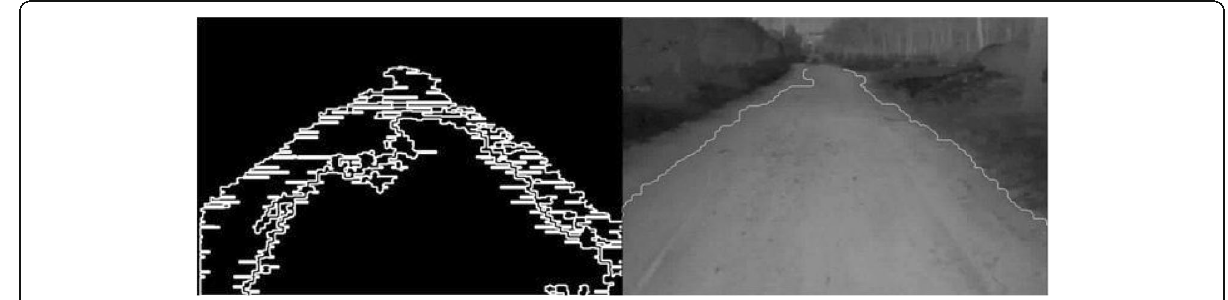
Fig. 21 K -means clustering and road boundary recognition. a Clustering result. b Road boundary